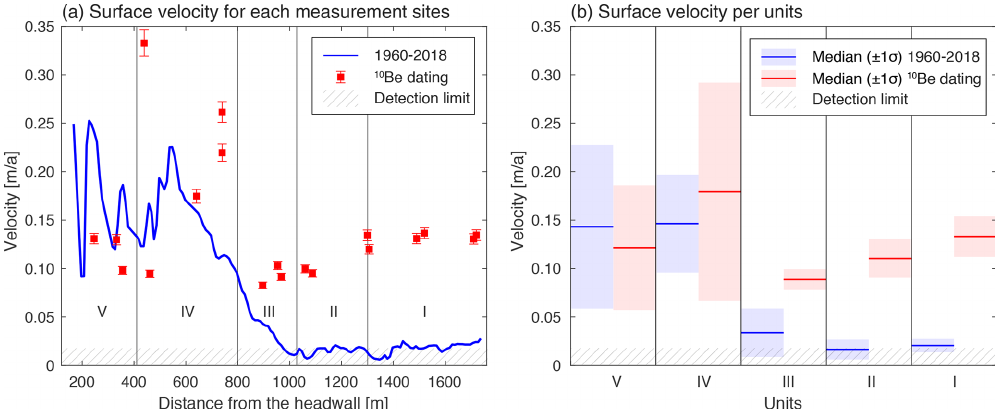
Figure 9. (a) Rock glacier surface velocity from 10 Be surface-exposure dating (distance from the headwall divided by the 10 Be surface- exposure age, shown as red squares) and from orthoimage correlation (IMCORR, SAGA package in QGIS, 1960–2018 interval, shown as a blue line). (b) Median surface velocities are presented for each independent method and each individual unit alongside their standard deviation ( ± 1 σ ). The dashed pattern represents the detection limit (0.026ma − 1 ) defined by median value of the control areas in Fig. 3 (used as a threshold value to detect rock glacier surface